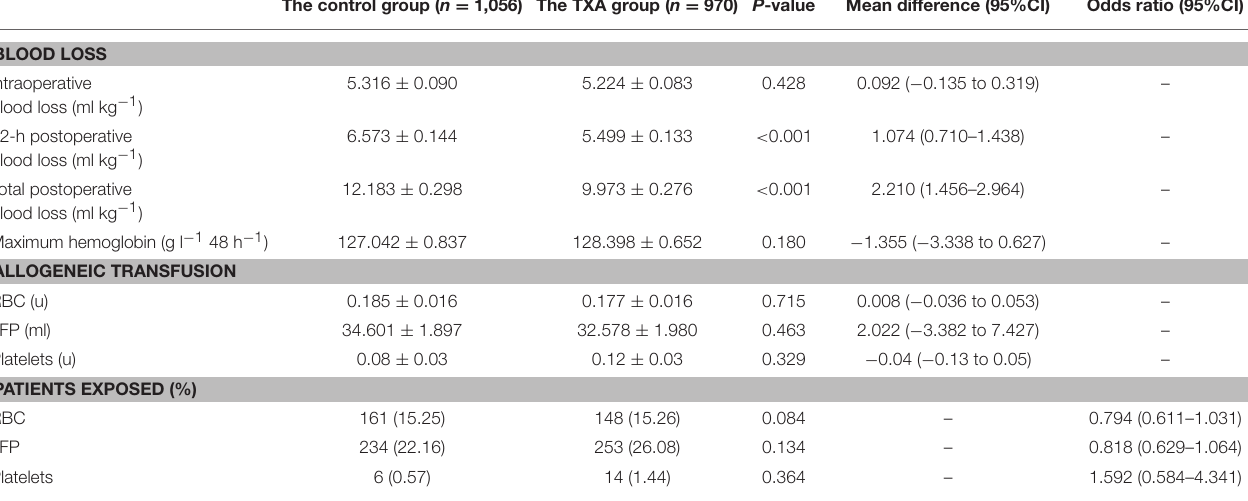
TABLE 2 | Blood loss and transfusion outcomes.